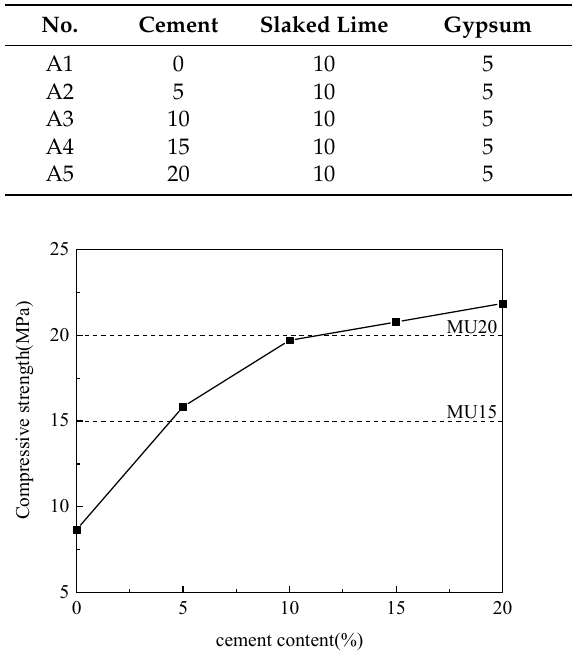
Figure 4. Effect of cement content on compressive strength.